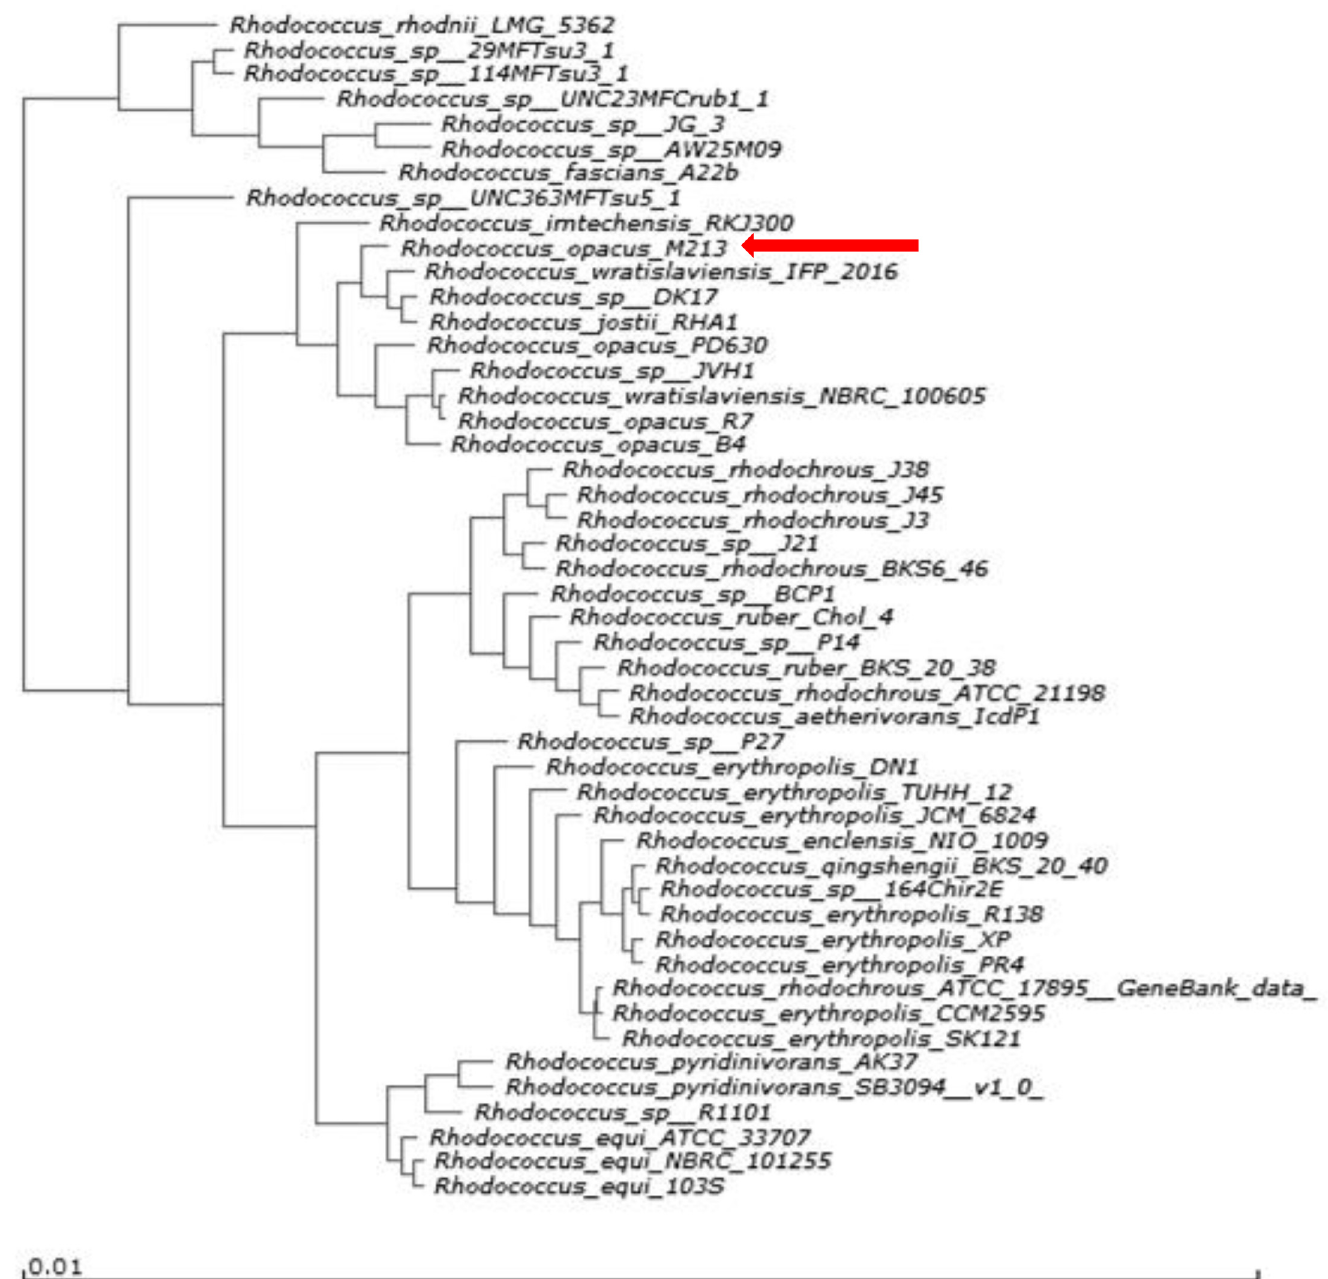
Fig 4. Phylogenetic tree obtained based on the presence of clusters of orthologous groups of proteins (COGs) from the genome of R . opacus strain M213 compared with a cohort of Rhodococcii for which whole genome sequences are available.